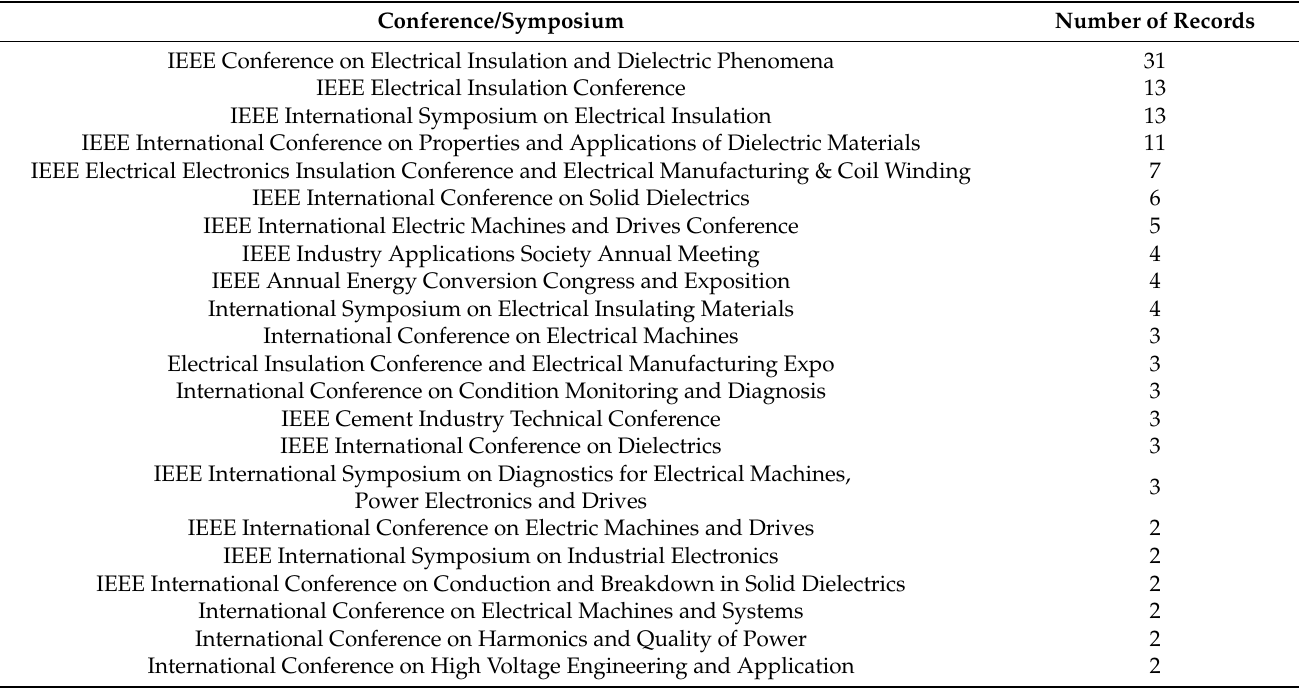
Table 4. Number of articles presented in respective conference or symposium.